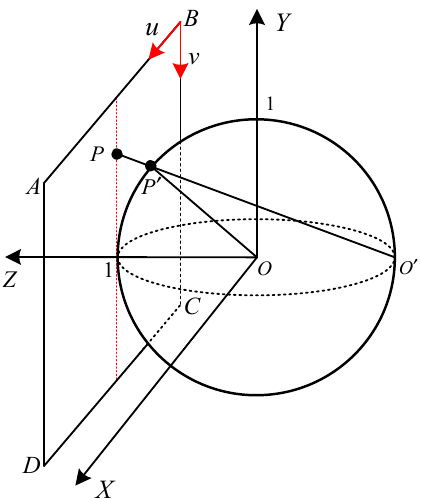
Figure 4. UV plane and sphere when the stereographic projection is used.